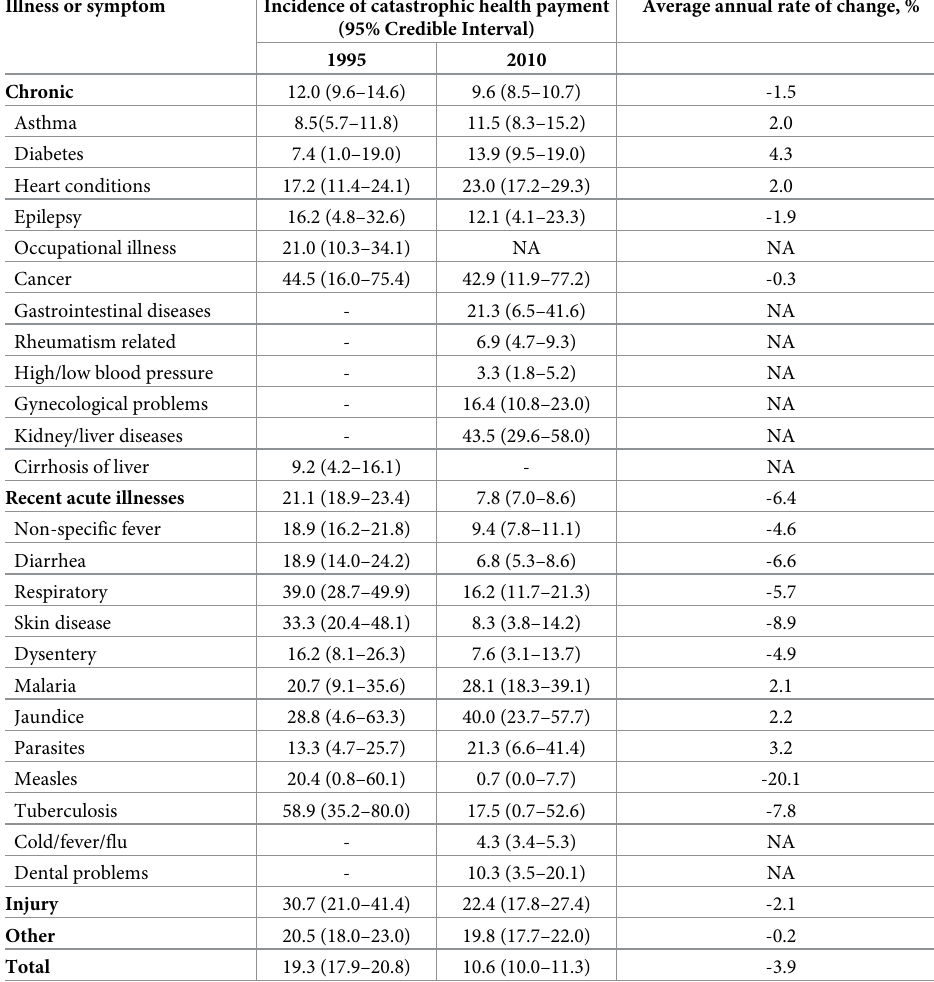
Table 5. Disease-specific catastrophic health payment at 10% of total consumption threshold in Nepal 1995–